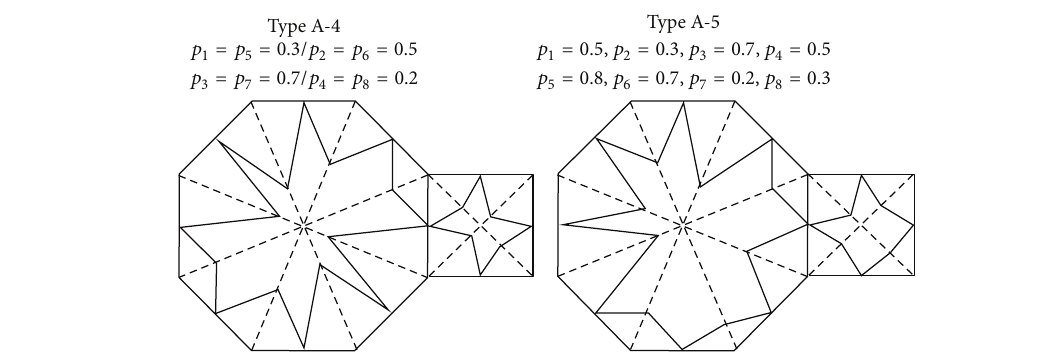
Figure 21: Examples of additional variations: Type A.